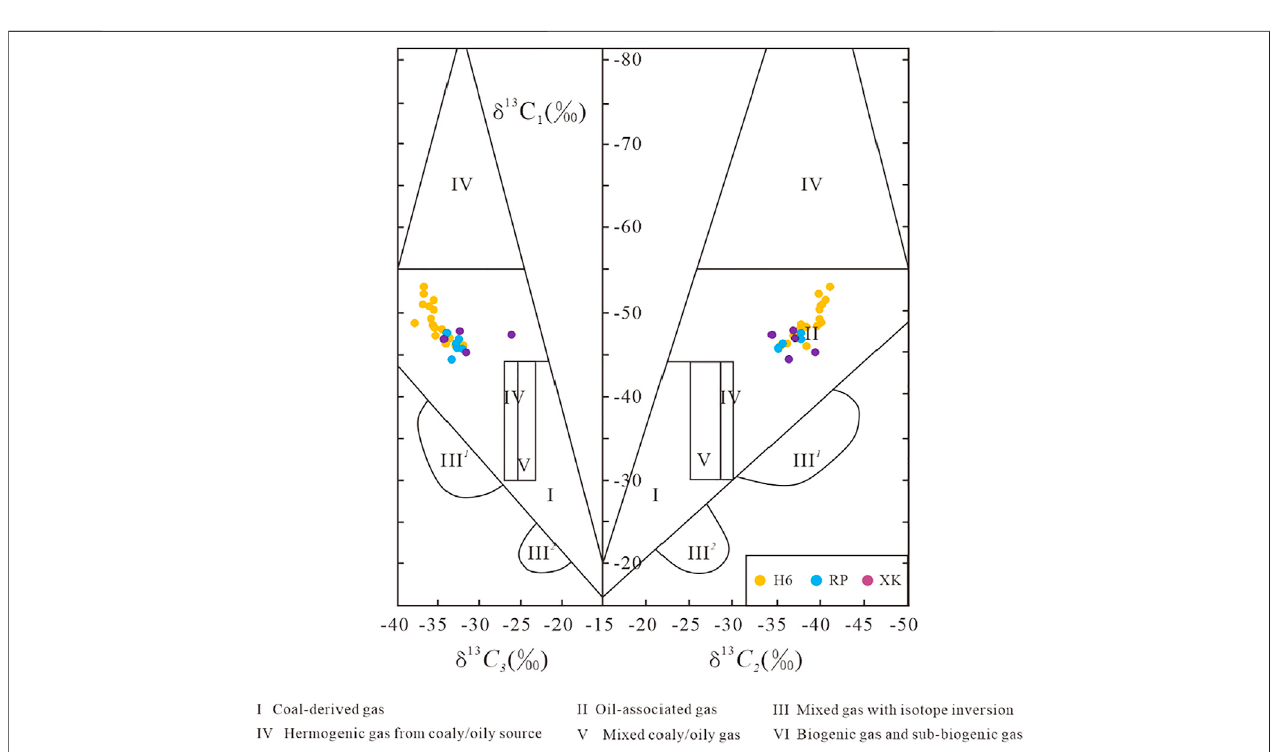
Frontiers in Earth Science |